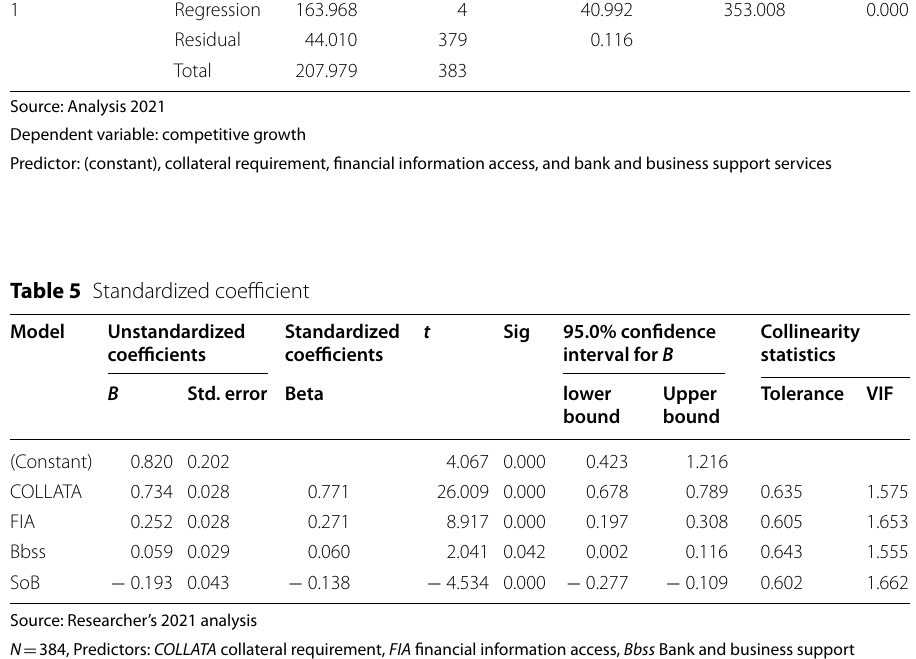
Source: Researcher’s 2021